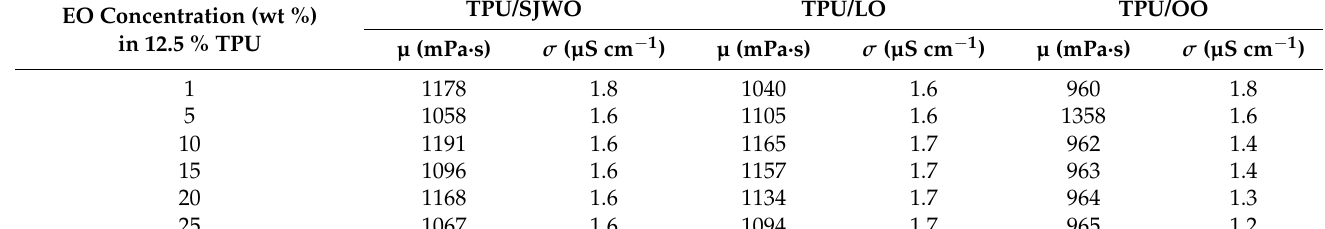
Table 2. Characteristic properties of TPU/essential oil solutions: electric conductivity ( σ ), viscosity